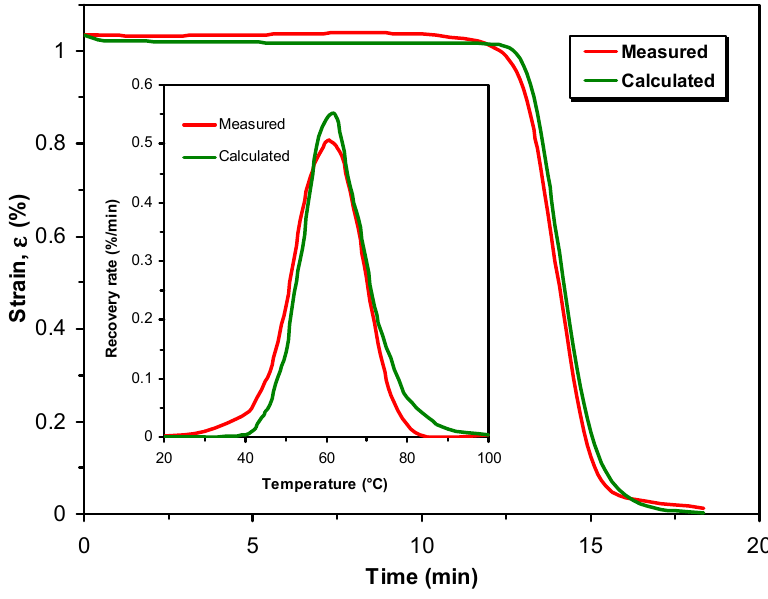
Figure 12. The measured and the calculated free recovery curves for a SMEP. The inset shows the measured and calculated recovery rates as a function of temperature. Reconstructed based on Ref. [225].